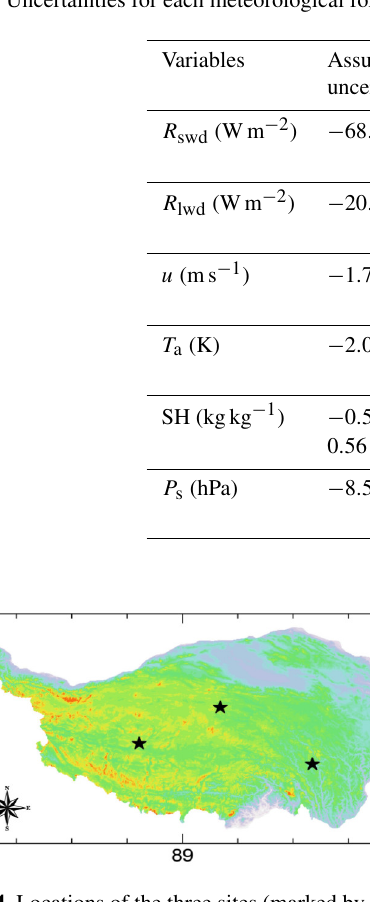
Figure 4. Locations of the three sites (marked by pentagrams) used to carry out sensitivity tests of the meteorological forcing input data. The legend of the color map indicates the elevation above mean sea level in